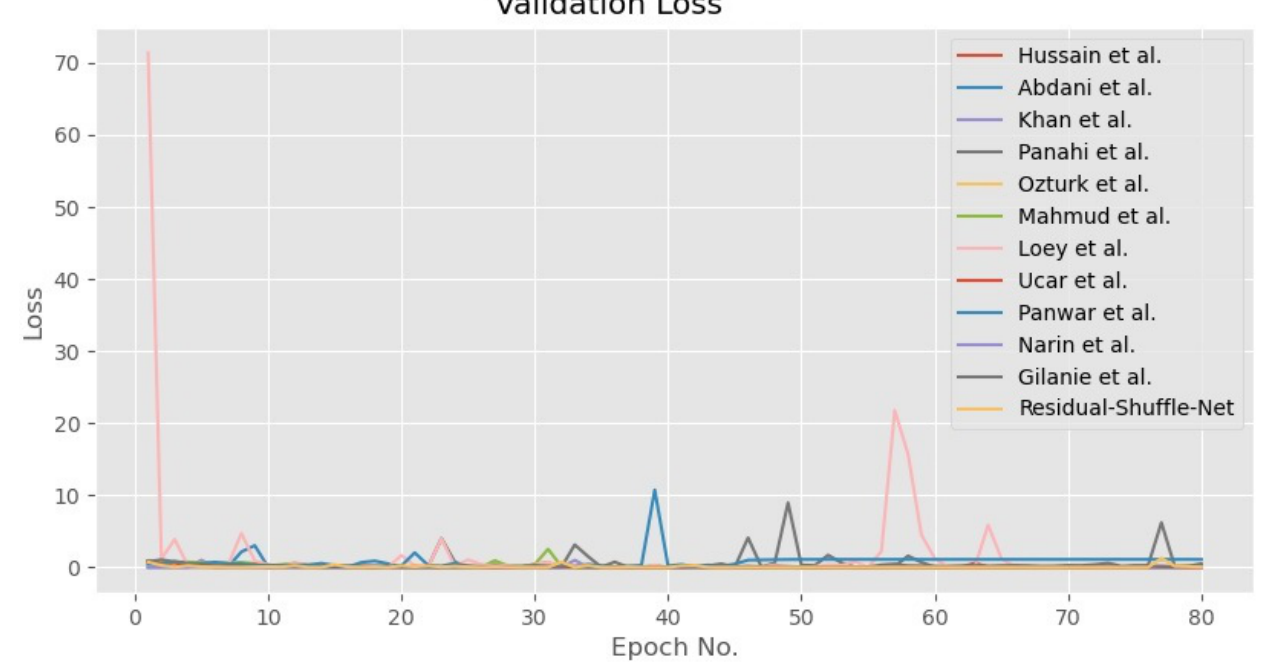
Figure 7. Validation loss for the Residual-Shuffle-Net and all of its benchmark methods. Table 3. Performance results of the Residual-Shuffle-Net and the benchmark